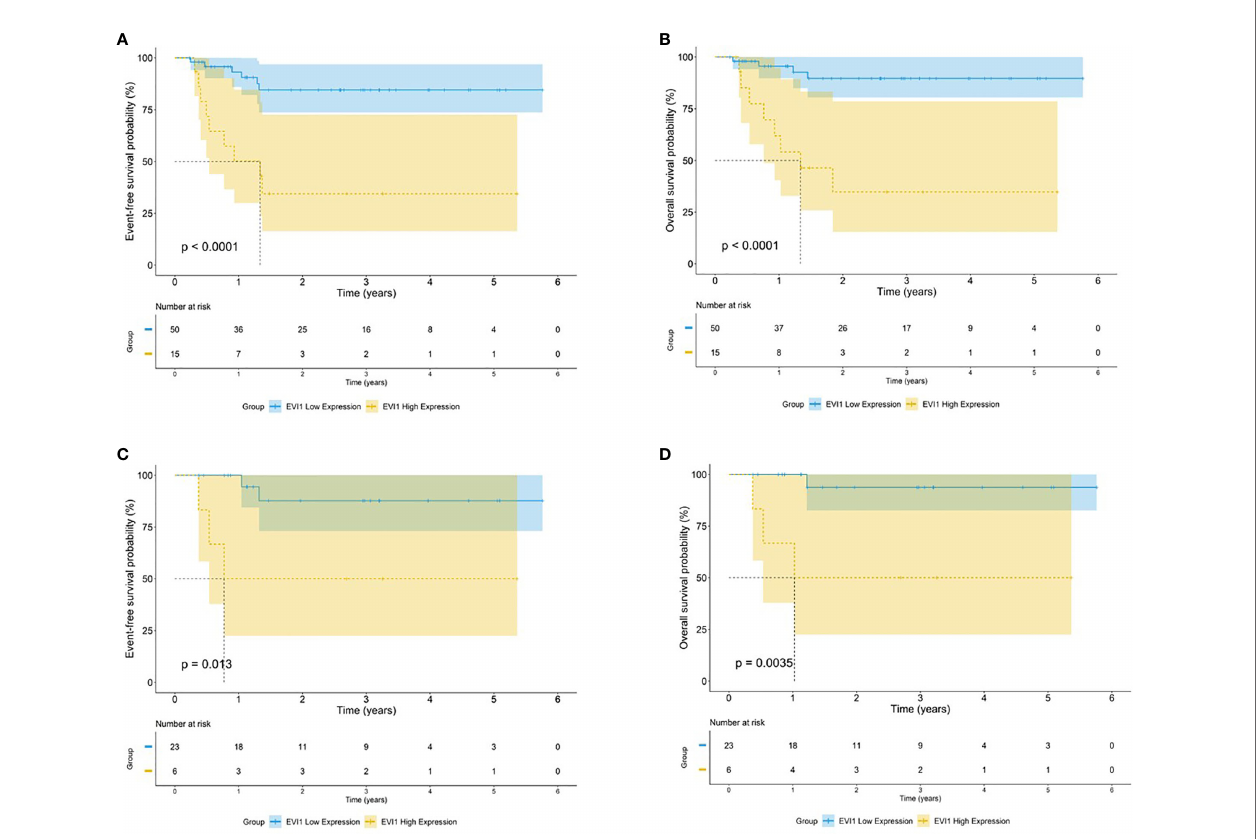
FIGURE 4 | Survival outcomes by EVI1 expression among patients carrying t(v;11). Kaplan – Meier curve estimates for the (A) EFS and (B) OS in the cohort of MLL rearranged AML between EVI1 high and EVI1 low patients. Kaplan – Meier curve estimates for the (C) EFS and (D) OS in the cohort of MLL-AF9 rearranged AML between EVI1 high and EVI1 low